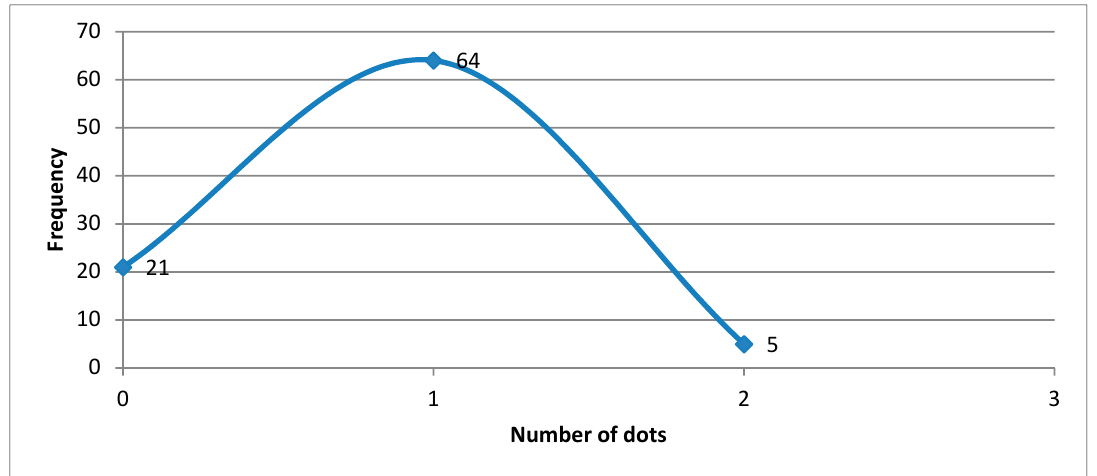
Figure 6. Quadrat analysis of NZBM. Source: Author.